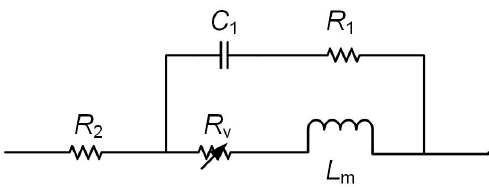
Figure A3. Equivalent lumped element model of the inductor .